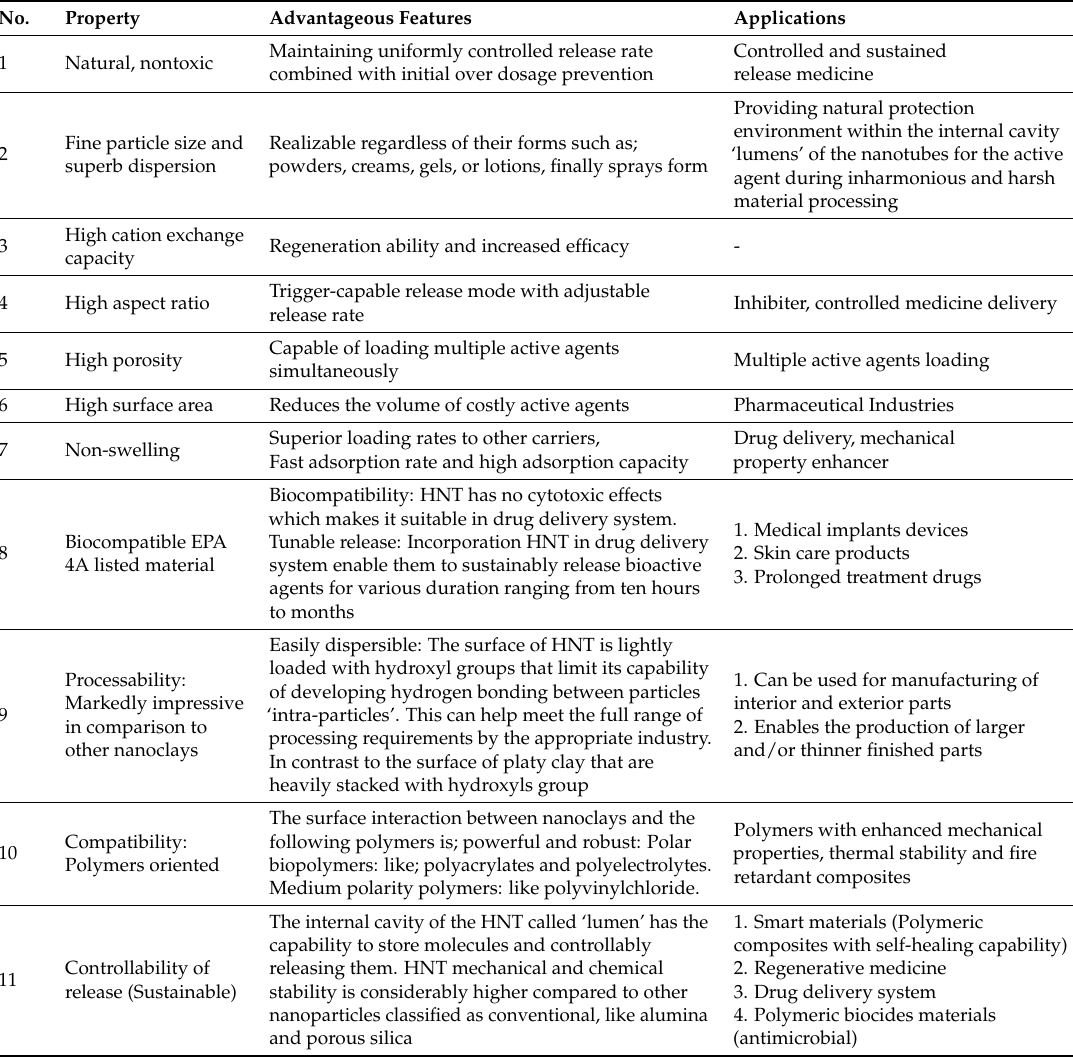
Table 1. Summary of the main properties